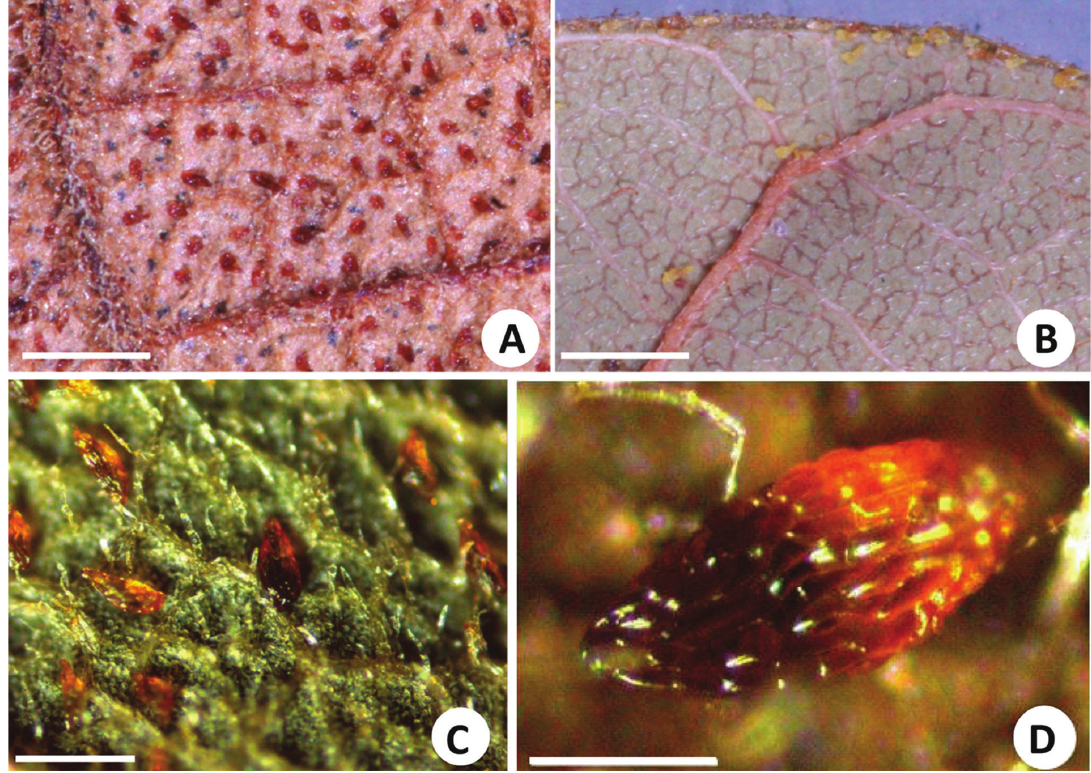
Figure 4 - Abaxial surfaces of leaves of species of subgenus Bauhinia . ( A ) B. bombaciflora (RB 213381), scale bar= 1 mm. ( B ) B. galpinii , scale bar= 1 mm. ( C ) B. ovata (SPF 95043), scale bar= 100 µm. ( D ) B. subclavata (RB 312959), scale bar= 200 µm. Images obtained with digital camera and close-up lens ( A and B ) and stereomicroscope and computer processing ( C and D